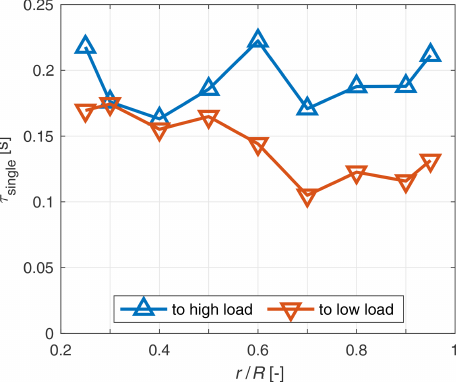
Figure 10. One-time-constant model fit of τ single to the axial wake induction factor over the radius for both pitch